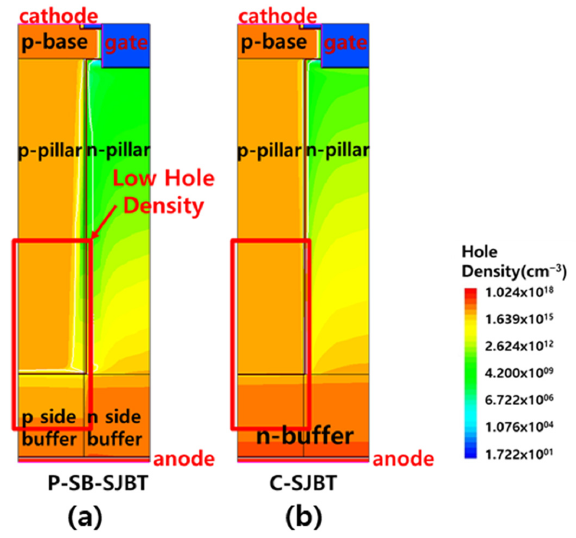
Figure 5. ( a ) Hole density of P-SB-SJBT, and ( b ) C-SJBT. Buffer concentration of ( a ) consist of 3 × 10 (cid:2869)(cid:2875) cm − 3 and 3 × 10 (cid:2869)(cid:2874) cm − 3 , and concentration of ( b ) consist of only 3 × 10 (cid:2869)(cid:2874) cm − 3 .